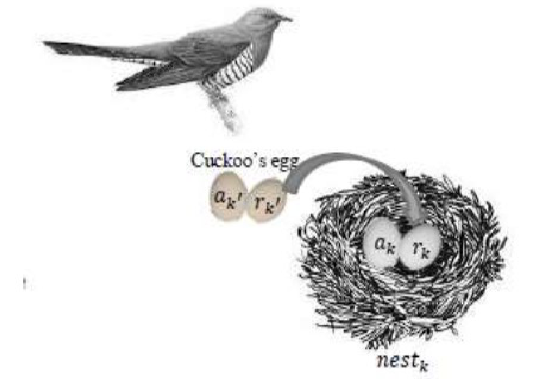
Figure 4. Placing the Egg on nest